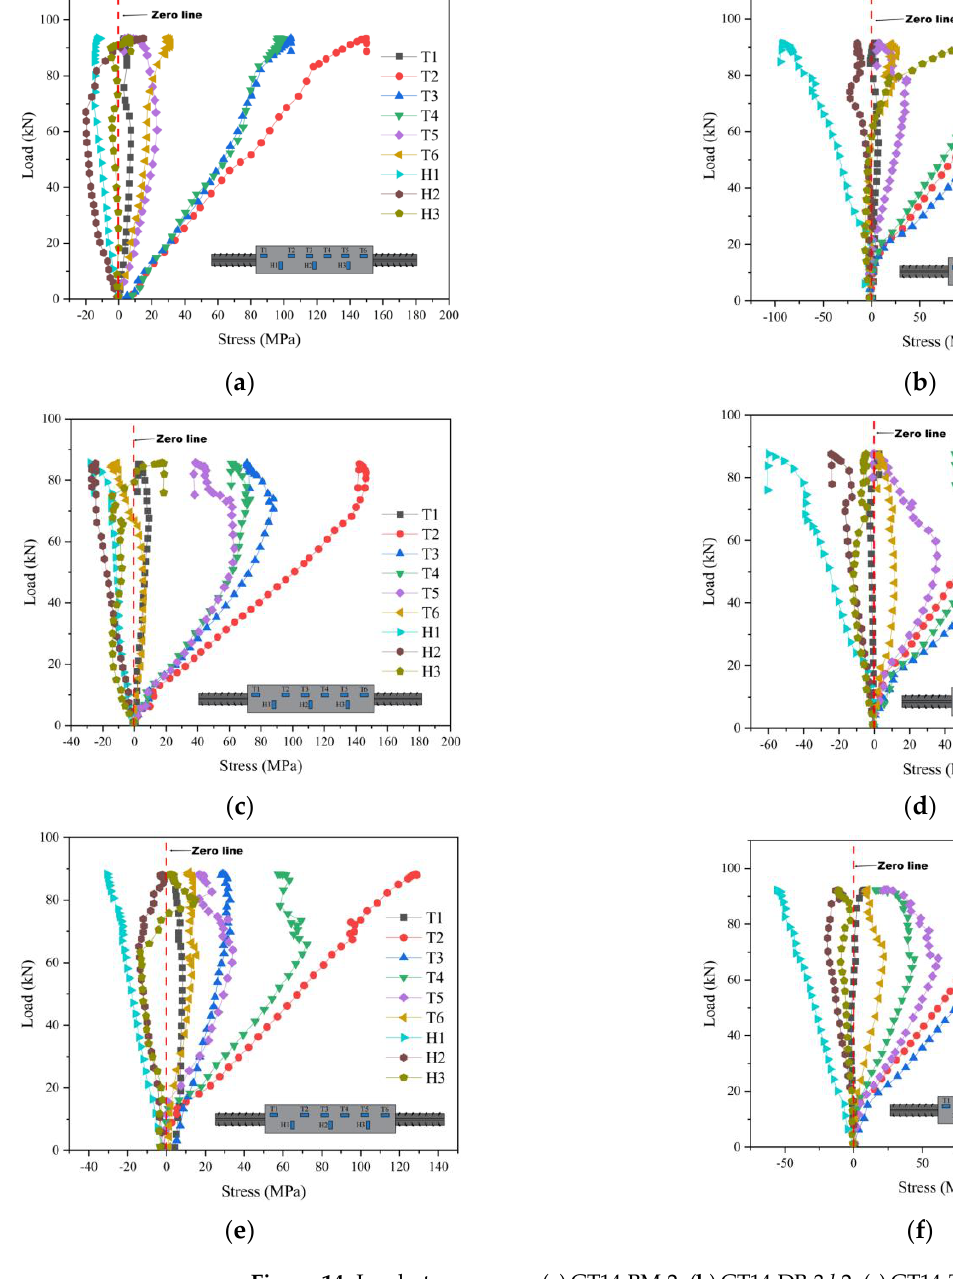
Figure 14. Load – stress curves. ( a ) GT14-BM-2. ( b ) GT14-DB-3 d -2. ( c ) GT14-ZB-2.5 d -1. ( d ) GT14-JB- 3-2.5 d -1. ( e ) GT14-DC-3-2.5 d -2. ( f )